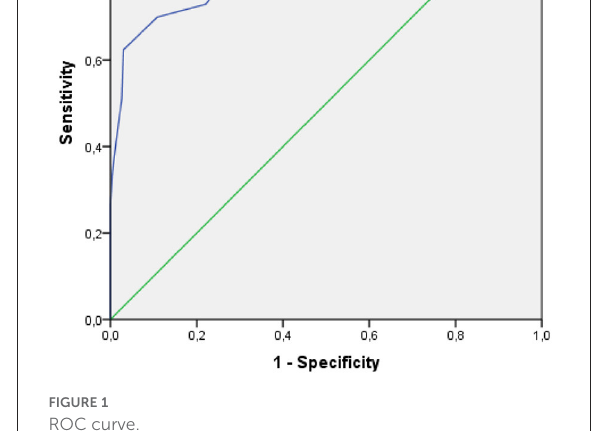
FIGURE1 ROC curve.